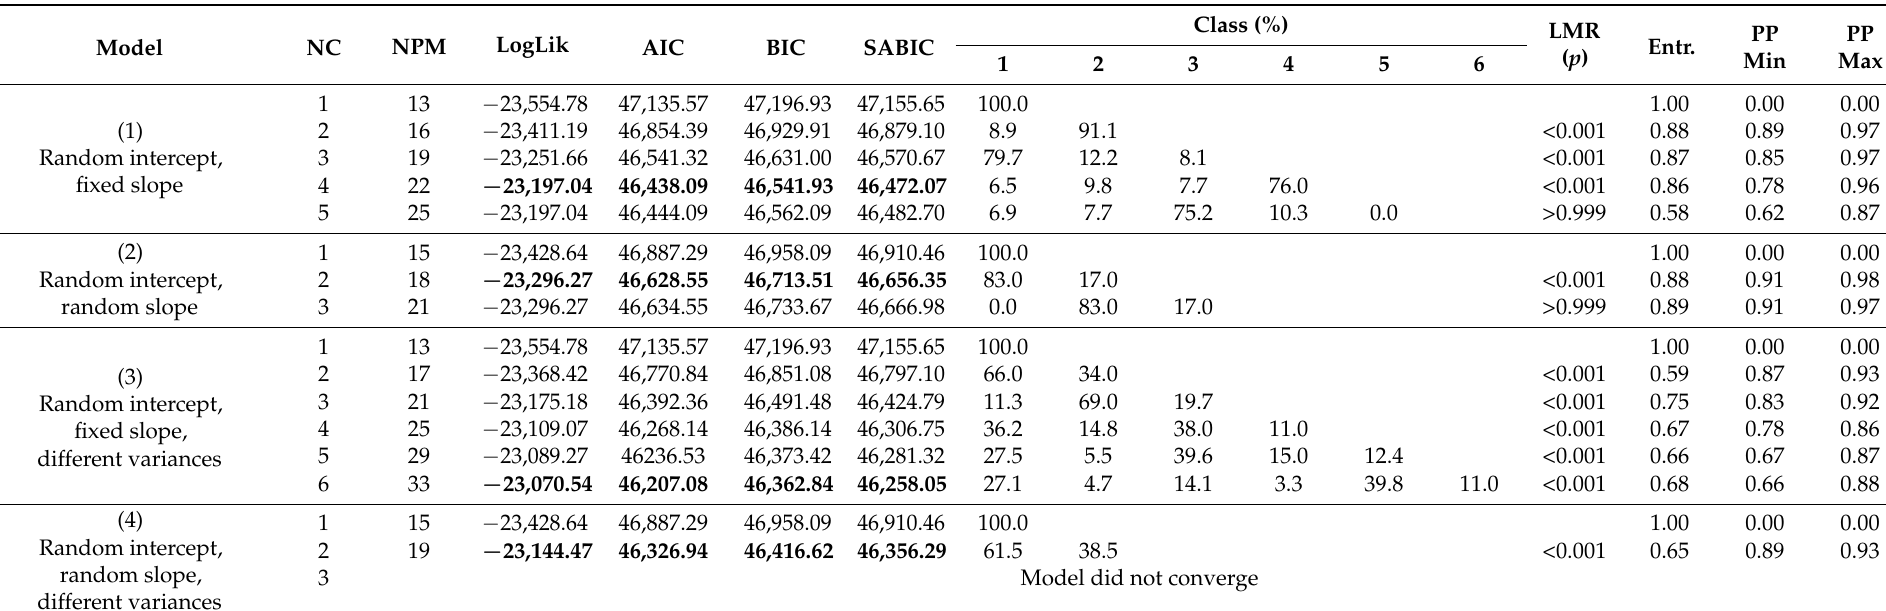
Table A9. Multivariate Latent Class Growth Analysis for PHQ-9, GAD-7, PCL-5 and RPQ for participants with complicated mild TBI (N =